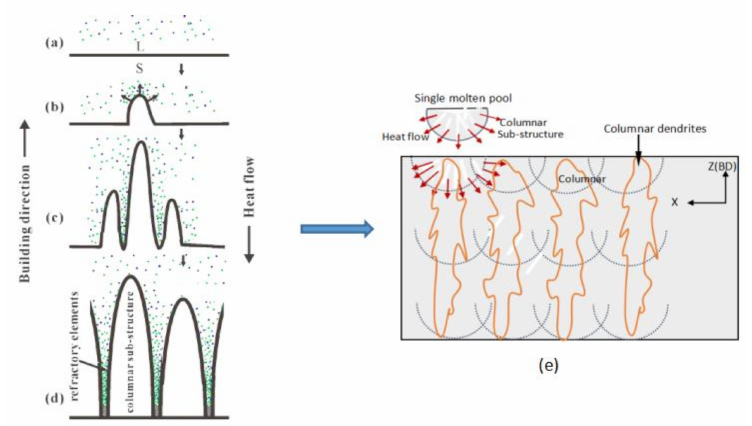
Figure 8. Schematic diagram of the growth process of columnar dendrites:( a ) initial plane solid/liquid interface;( b ) forming of first bulge on the interface;( c ) bulges grow along building direction;( d ) final columnar dendrites; ( e ) microstructures in the X-Z plane.